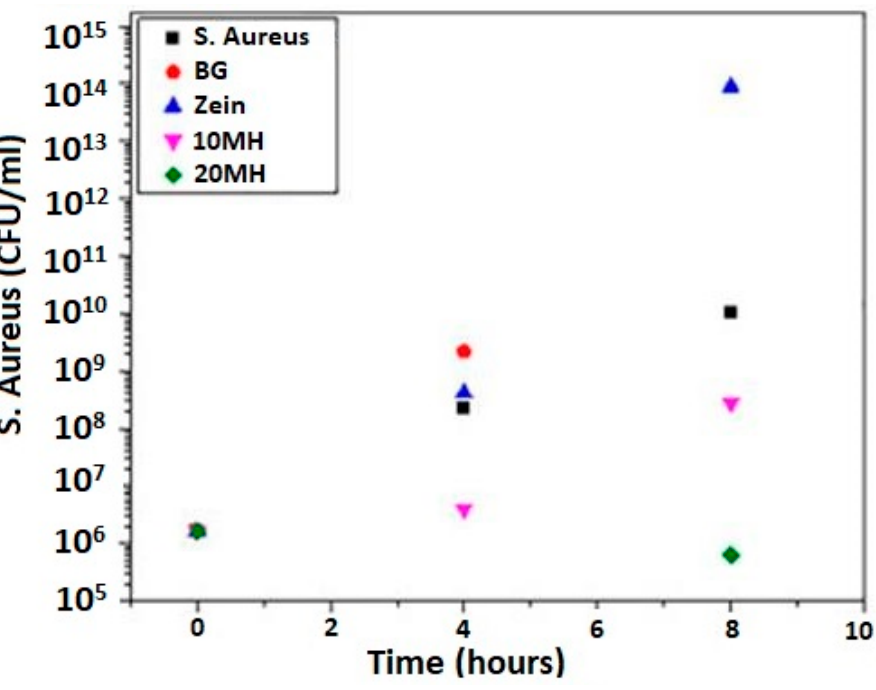
Figure 17. Antibacterial effect of MH/zein against S. aureus . Reproduced from [151] with permission from Frontiers™.